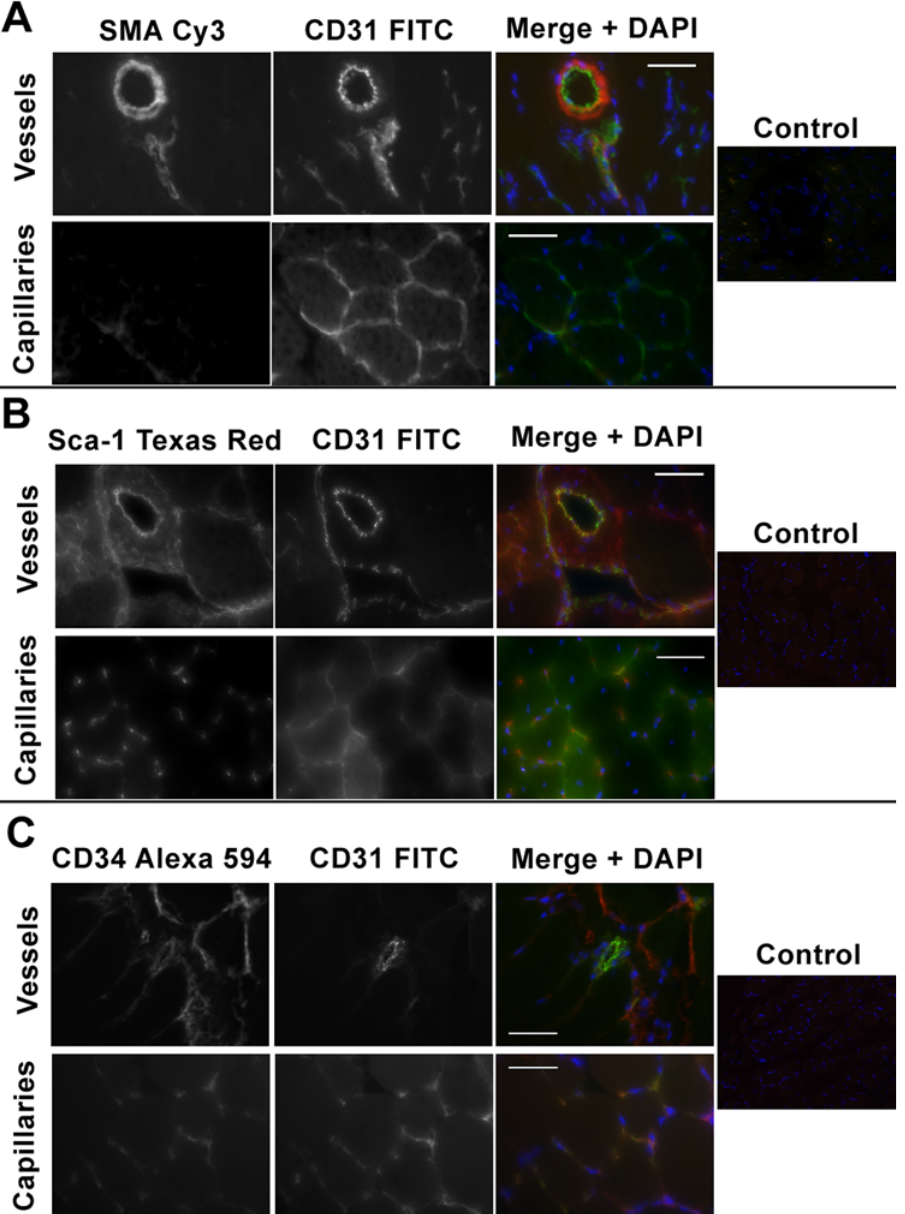
Figure 1. Endothelial cells of the skeletal muscle are CD31, Sca-1 and CD34 positive. Skeletal muscle tissue section staining for smooth muscle actin (SMA), CD31, Sca-1 and CD34 highlights vascular endothelial cells. All photographs were taken at 40x except controls which are at 10x. A, SMA Cy3 shows exclusive staining of the smooth muscles cells within veins and arteries and does not overlap with CD31 FITC staining which is localized in the endothelial lining of vessels. B & C, CD31 FITC positive vasculature is also positive for Sca-1 Texas Red and CD34 Alexa 594. Scale bar=50 m m.